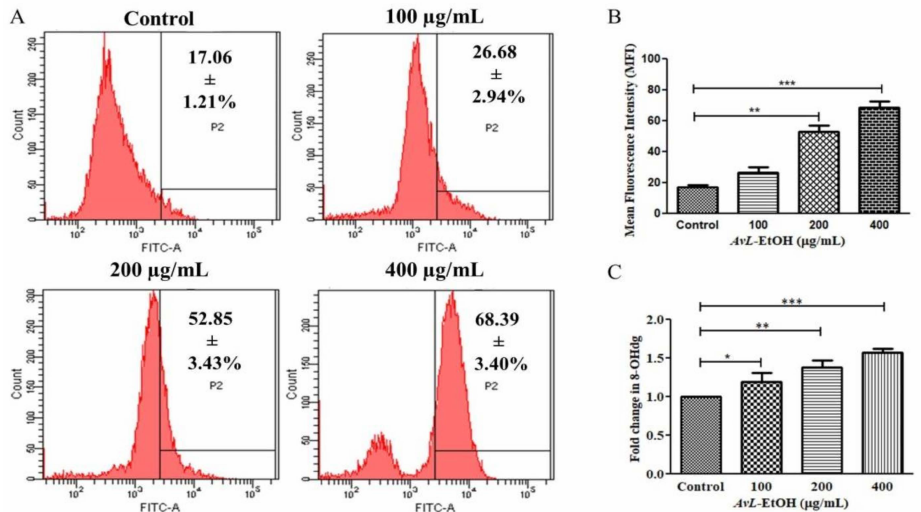
Figure 11. ( A ) Flow cytometric evaluation of ROS augmentation, ( B ) quantification of flow cytometry data indicating ROS augmentation ( n = 3) and ( C ) fold change in the levels of 8-OHdG indicating DNA damage within A549 cells after treatment with varying concentrations of AvL -EtOH (100, 200 and 400 µ g/mL). * p < 0.05, ** p < 0.01 and *** p <